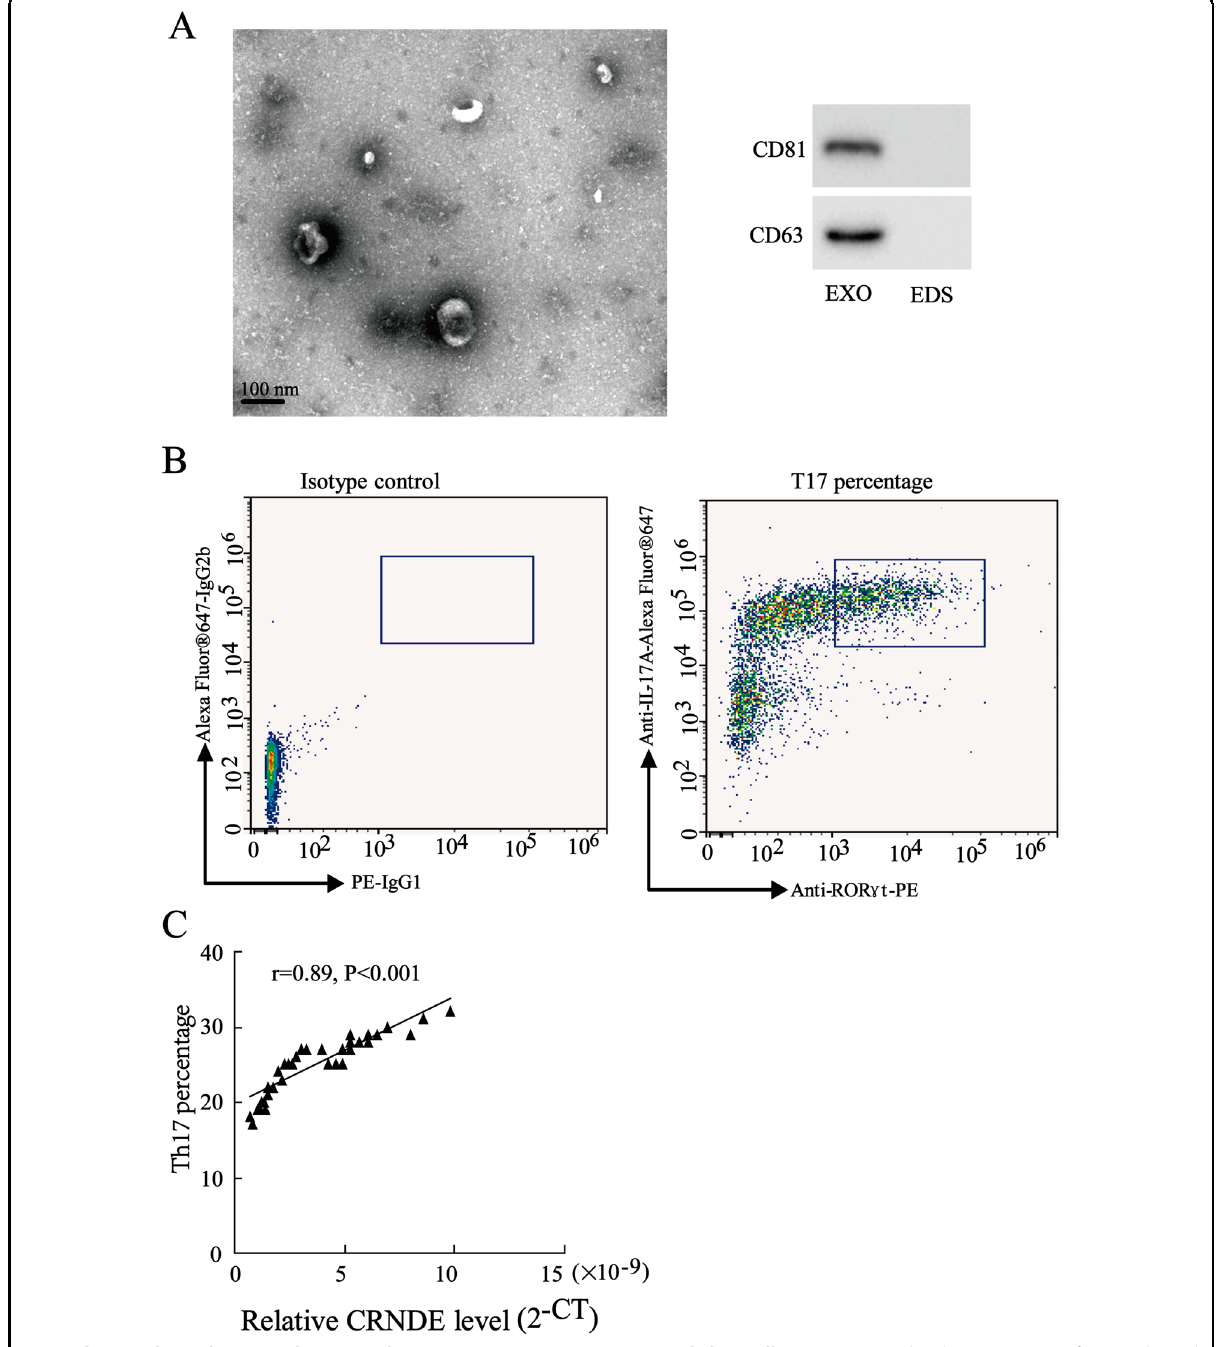
Fig. 1 The correlation between the CRNED-h expression in serum-exosome and Th17 cell proportion. A The characterization of serum-derived exosome was determined by transmission electron micrograph, and western blot analysis was used to detect positive exosomal markers. B The proportion of Th17 cells in the tumor-in fi ltrating T cells isolated from CRC patients was detected by fl ow cytometry. C The correlation between the expression of CRNDE-h in the serum-derived exosome from 42 CRC patients and the proportion of Th17 cells in tumor-in fi ltrating T cells. EXO exosome, EDS exosome depleted